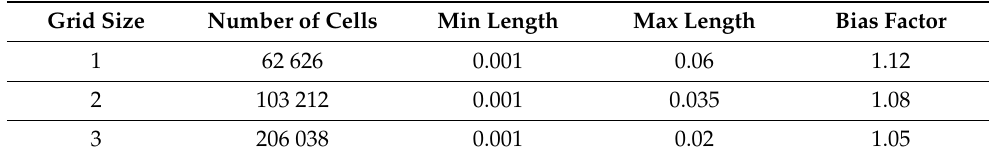
Table 1. Grid properties of the three grid sizes for the grid-sensitivity